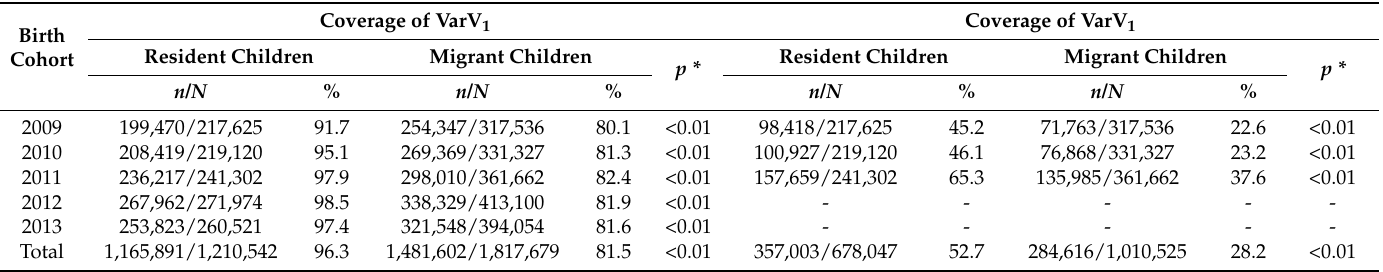
Table 4. Vaccination coverage of VarV for children born from 2009 to 2013 in Zhejiang province, by immigration status.